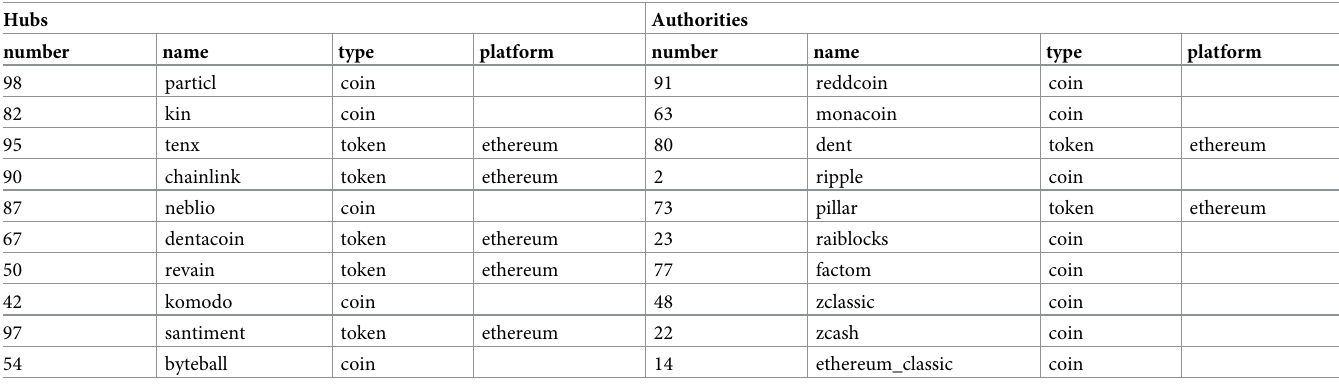
Table 5. Hubs and authorities.